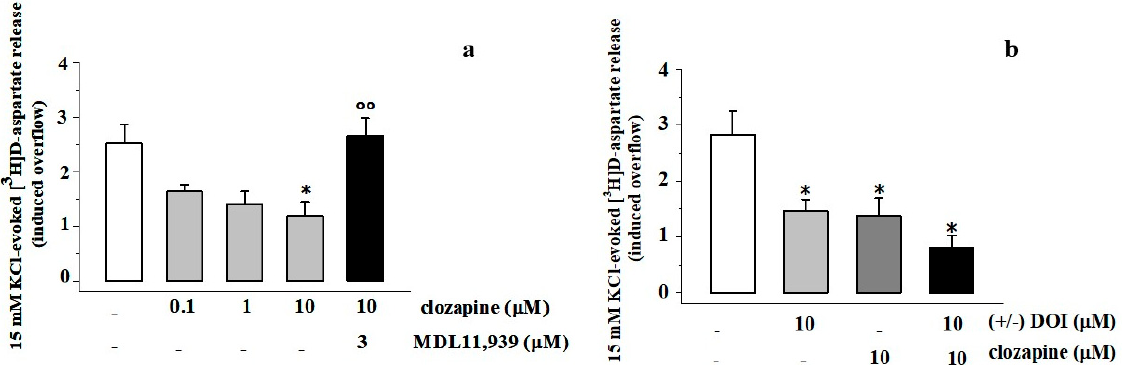
Figure 4. Clozapine inhibits the 15 mM KCl-evoked [ 3 H]D-aspartate in synaptosomes from the PFc of adult rats: reversal by MDL11,939. ( a ) Concentration dependent clozapine (0.1–10 µ M) inhibits the 15 mM KCl-evoked [ 3 H]D-asp exocytosis from PFc synaptosomes in a MDL11,939-dependent fashion. The release of [ 3 H]D-asp in the first 3 min fraction collected (b1) amounted to 0.56 ± 0.03 nCi and represents the 1.01 ± 0.06% of the total tritium synaptosomal content. ( b ) Effects of 10 µ M ( ± ) DOI and 10 µ M clozapine alone or concomitantly added on the 15 mM KCl evoked [ 3 H]D-asp exocytosis from prefrontal cortex synaptosomes. The release of [ 3 H]D-asp in the first 3 min fraction collected (b1) amounted to 0.57 ± 0.06 nCi and represents the 1.12 ± 0.09% of the total tritium synaptosomal content. Results are expressed as induced overflow; data are the means ± SEM of five to six experiments run in triplicate. * p < 0.05 vs. respective 15 mM KCl; ◦◦ p < 0.001 vs. 15 mM KCl/10 µ M clozapine.